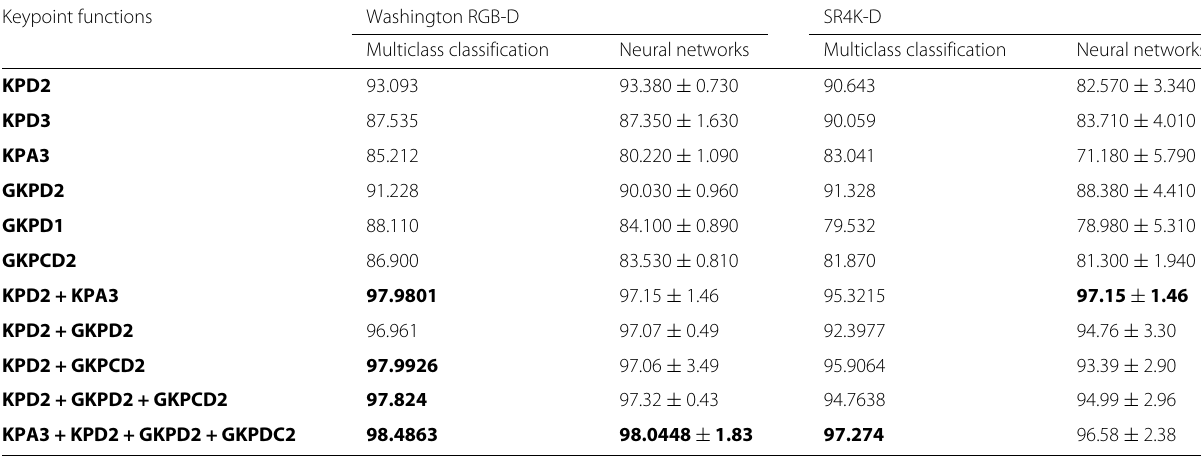
Table 2 Classification accuracy rate in percent with shape keypoint functions Keypoint functions